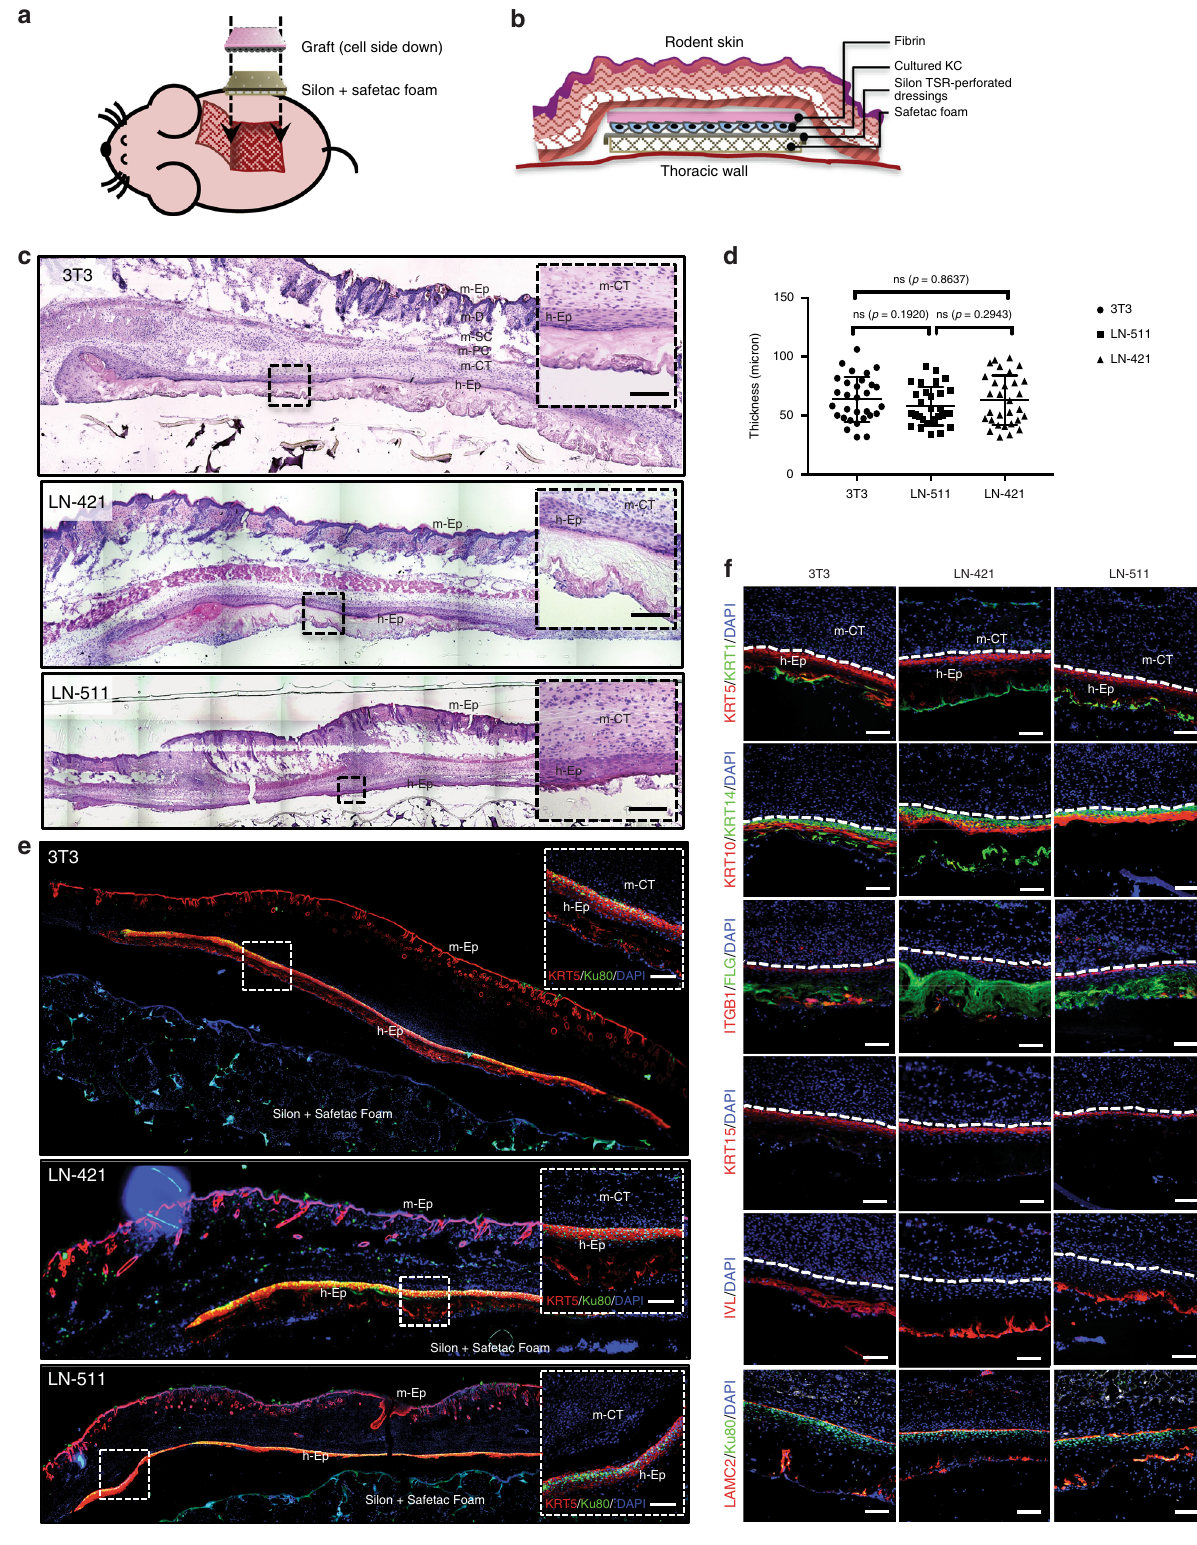
Methods Primary keratinocyte isolation . HEKs were isolated from surgical waste from plastic surgery operations of healthy subjects, with informed consent from these donors and ethics approval from SingHealth Centralised Institutional Review Board (CIRB#2014/283/D and CIRB#2015/3055). Brie fl y, a maximum of 4cm 2